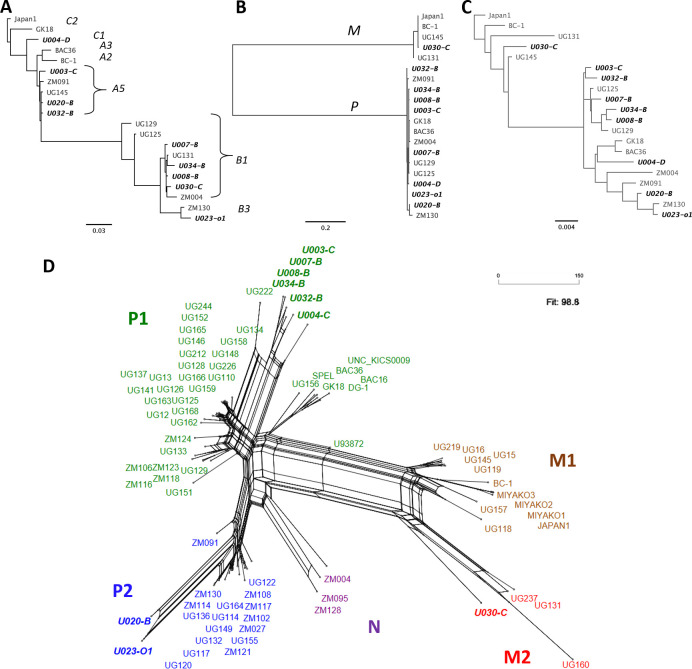
KSHV phylogenetic relationships in variable regions K1 and K15 and whole genomes.Phylogenetic trees of (A) K1 genes, (B) K15 genes and (C) whole genomes from this study and of select genomes from other publications. K1 and K15 subtypes are indicated in the K1 (A) and K15 (B) trees. (D) A neighbor-net phylogenetic network of all published KSHV genomes to date, color-coded by genome types proposed in [36]: P1 in green, P2 in blue, N in purple, M1 in brown and M2 in red. All de novo-assembled genomes from this study are in bolded italics.